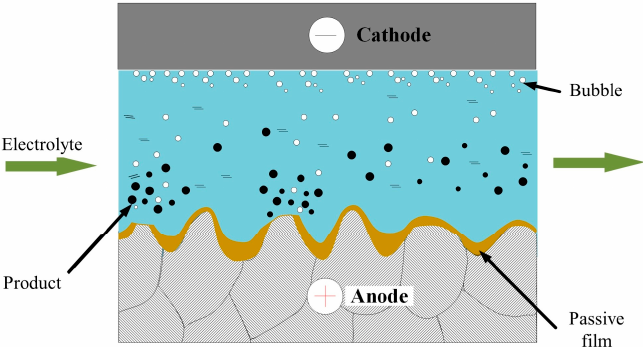
Figure 1. Polishing mechanism of conventional electrochemical polishing (ECP).